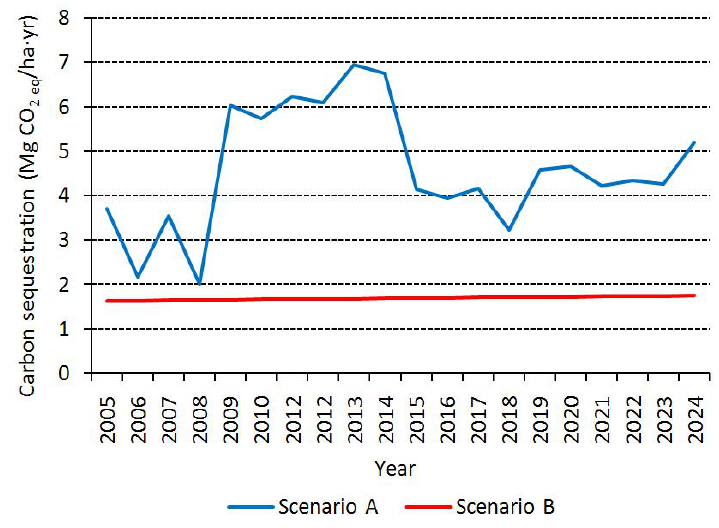
Figure 3. Carbon sequestration (Mg CO 2 eq /ha · y) in the studied scenarios.